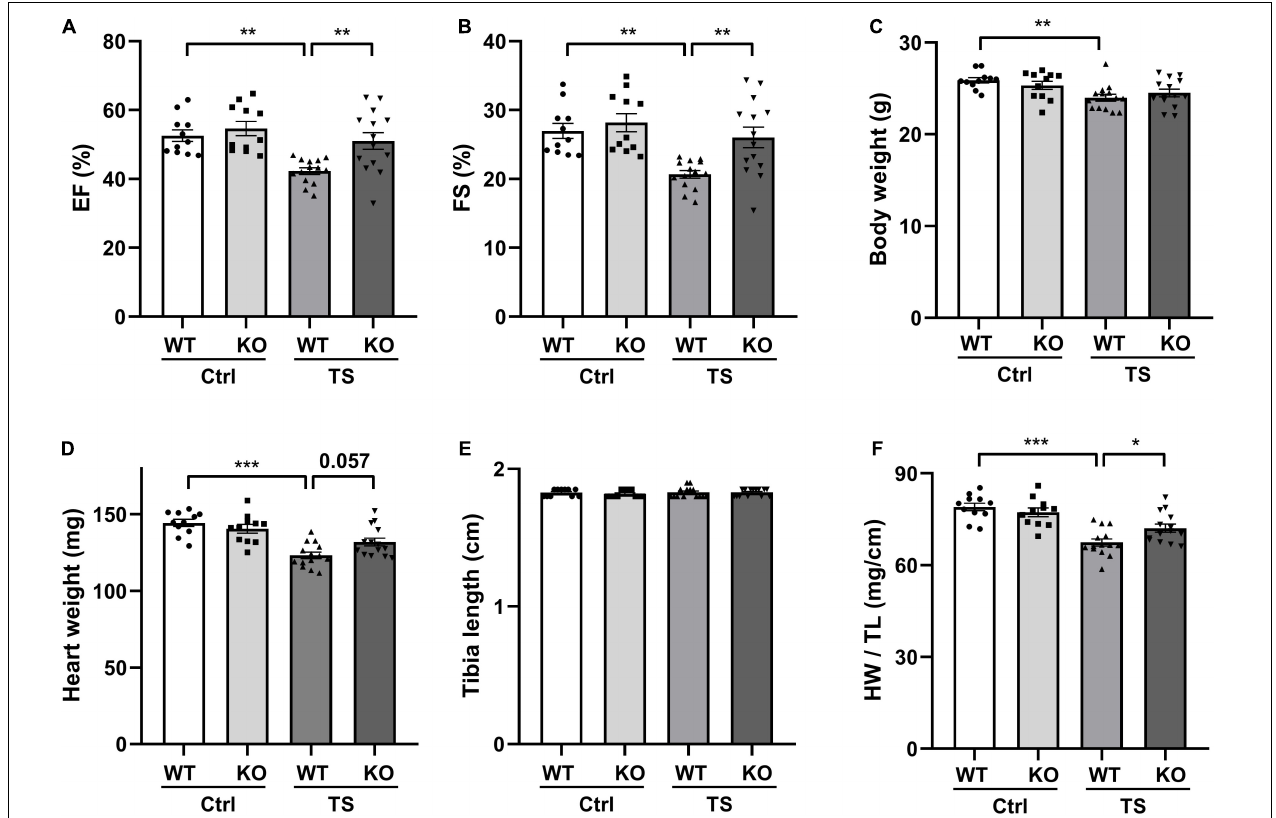
FIGURE 2 | WW domain-containing E3 ubiquitin protein ligase 1 knock out alleviates simulated microgravity-induced cardiac function decline. (A,B) Echocardiographic assessment of ejection fraction (EF) and fractional shortening (FS) of WT and WWP1 knockout (KO) mice after 6 weeks of tail suspension. (C–F) Body weight, heart weight, tibia length, and the ratio of heart weight to tibia length of wild-type (WT) and WWP1 KO mice after 6 weeks of tail suspension. Data represent the means ± SEM. * P < 0.05, ** P < 0.01, *** P < 0.001. Ctrl, control; TS, tail suspension; WT, wild-type mice; KO,